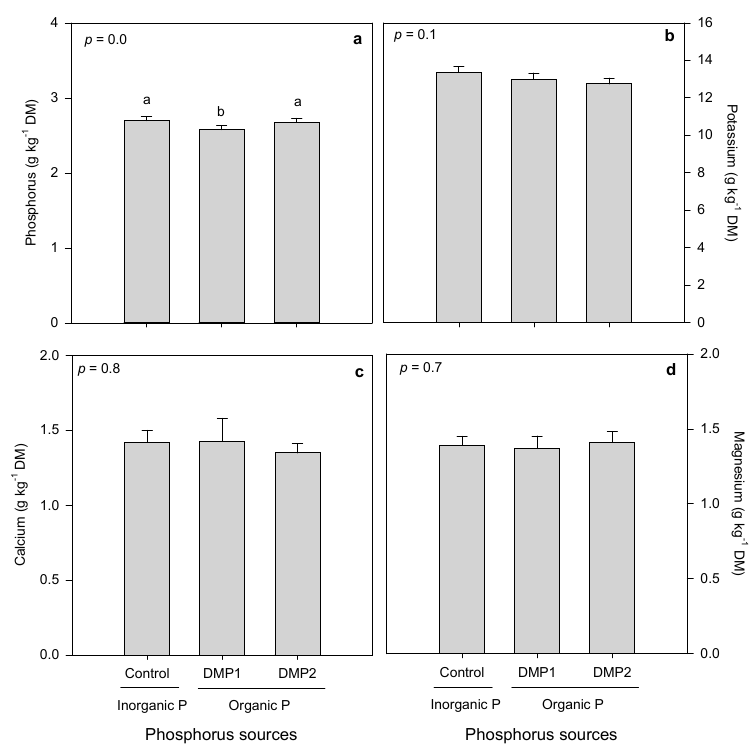
Figure 2. Effects of inorganic and organic phosphorus amendments on forage minerals of silage-corn ( a ) phosphorus, ( b ) potassium, ( c ) calcium and ( d ) magnesium grown in boreal climate. Each bar represents mean of three replications ± SE.